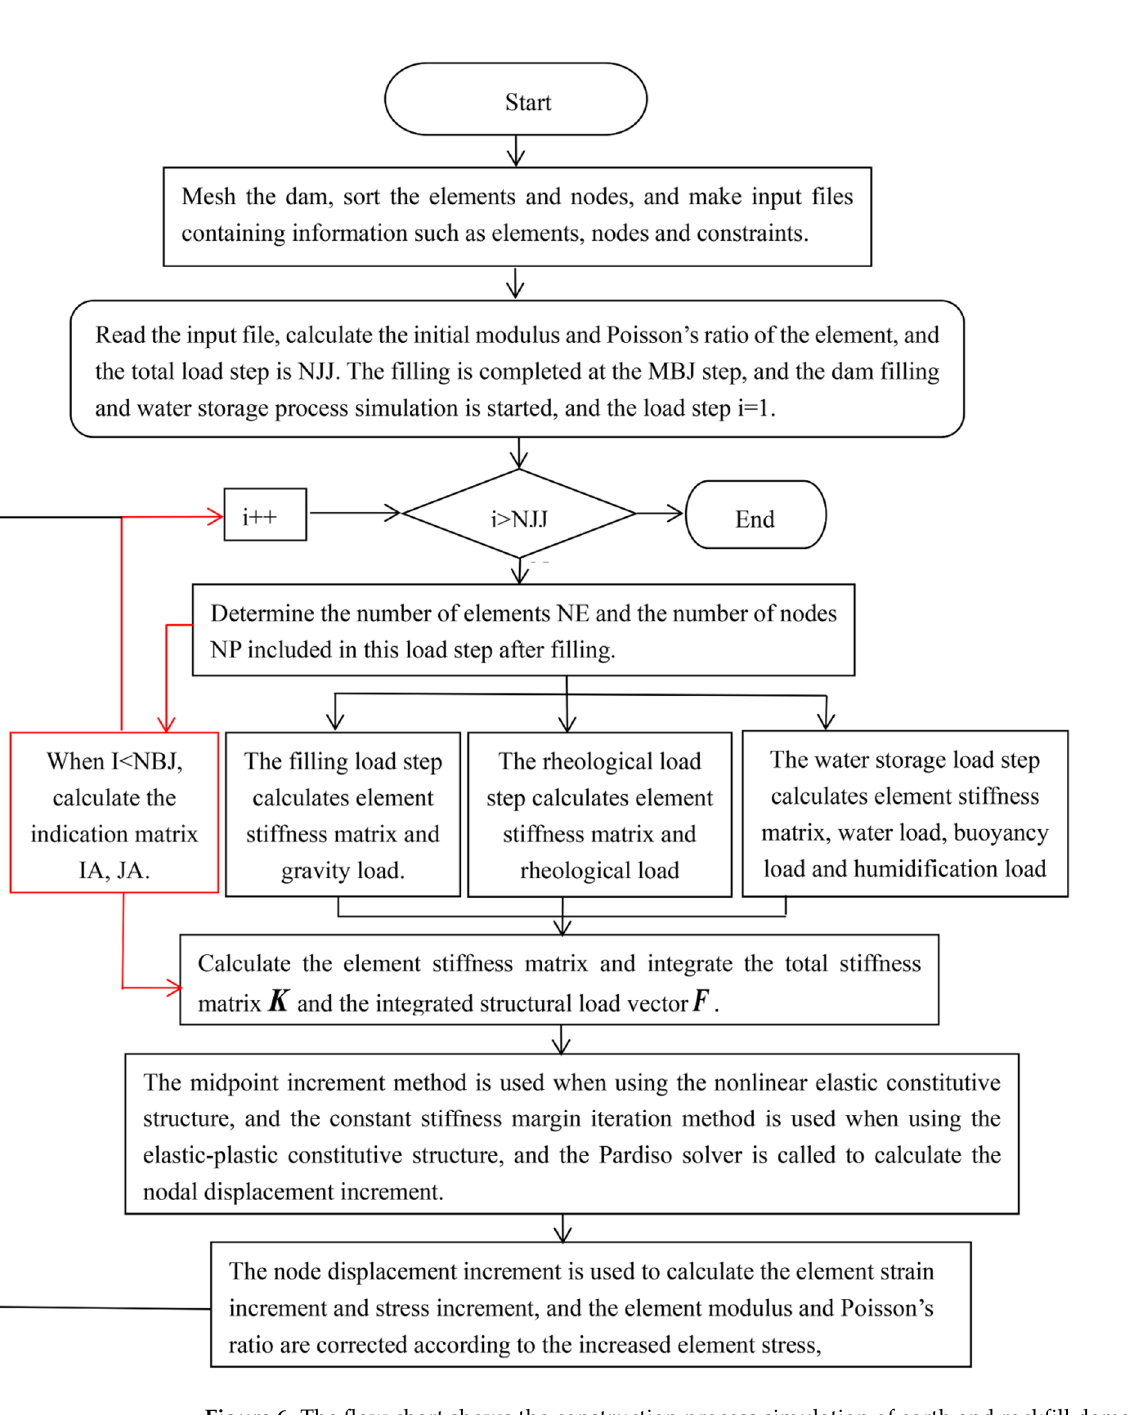
Figure 6. The flow chart shows the construction process simulation of earth and rockfill